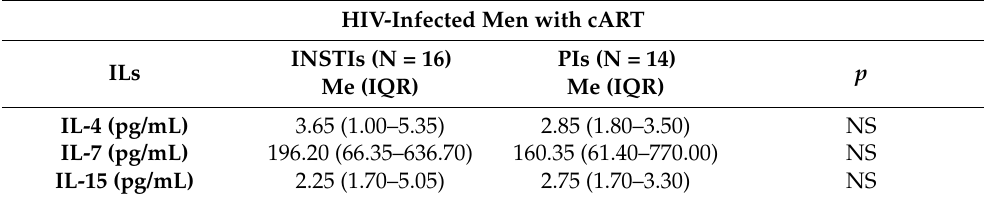
Table 6. Results of Il-4, -7 and -15 in HIV-infected men after cART in the subgroup with Protease inhibitors (PIs) treatment and the subgroup with Integrase transfer inhibitors (INSTIs) treatment with statistical analysis.